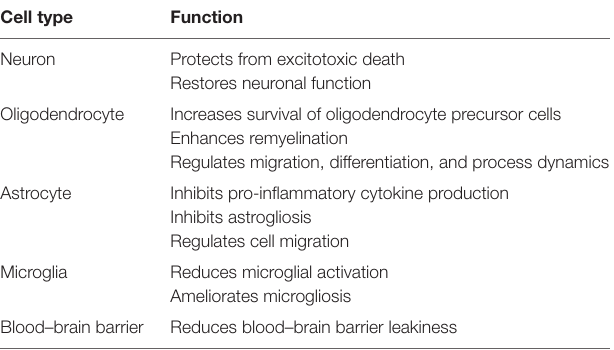
taBLe 2 | Central nervous system effect of fingolimod